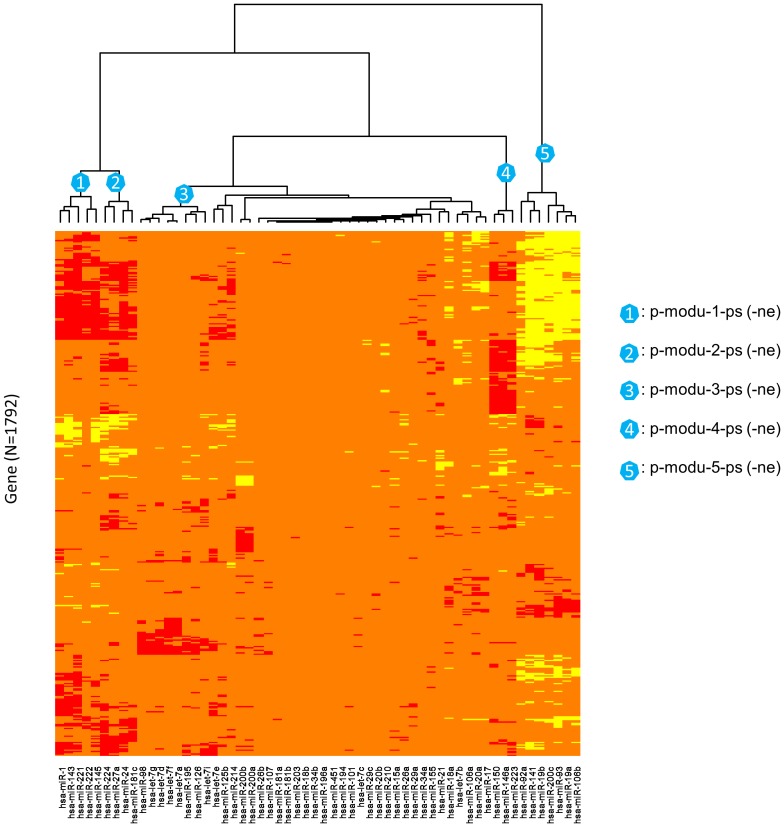
Identifying miRNA-mRNA correlation-network modules in primary prostate cancer (PPC) by the hierarchical clustering algorithm.Red: the top 1% positive correlations. Yellow: the top 1% negative correlations. Orange: pseudo or unconsidered correlations.